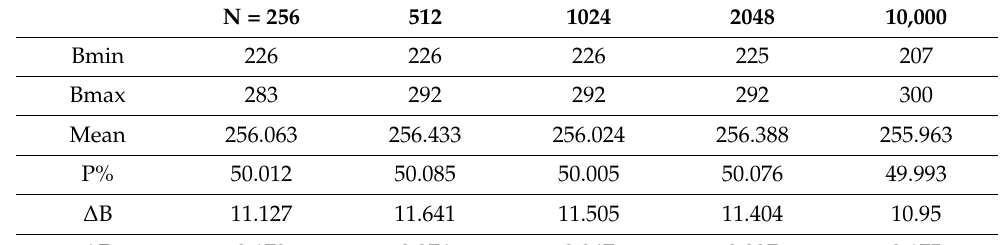
Table 12. Statically results for structure 4 for a number of different tests.